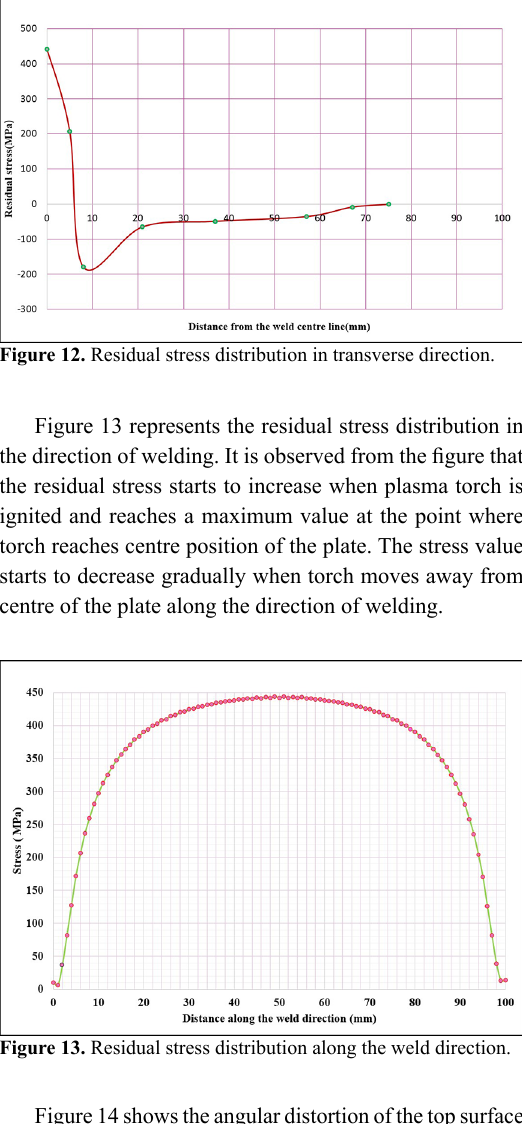
Figure 13. Residual stress distribution along the weld direction.